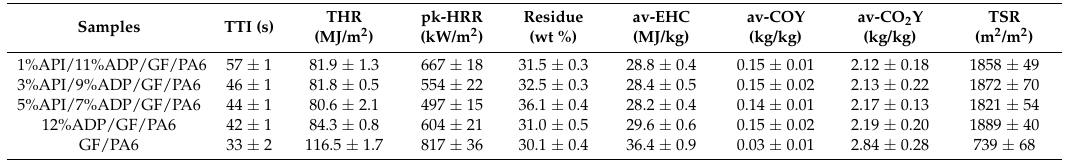
Table 4. Typical parameters of PA6 composites in the cone calorimetry